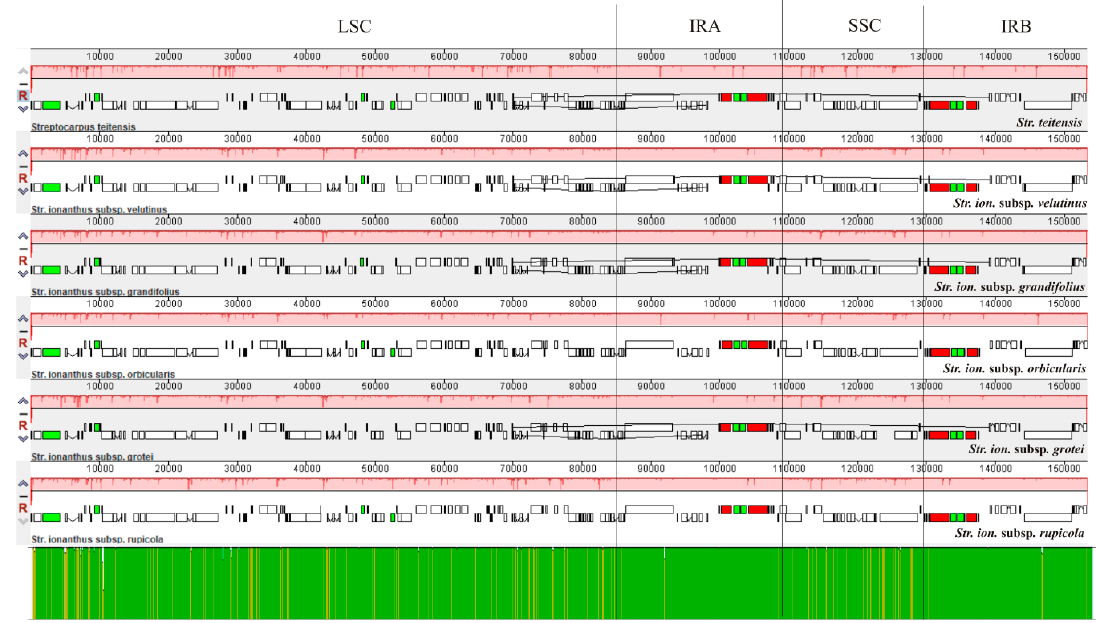
Figure 2. Multiple genome alignment of six sect. Saintpaulia taxa. The red bars represent sequence similarity among different genomes. The bottom bar is a visualization of the sequences’ consensus identities with the green color symbolizing homology while the yellow vertical lines signify variation spots. LSC: Large Single Copy region; IRA: Inverted Repeat A; SSC: Small Single Copy region and IRB: Inverted Repeat B.